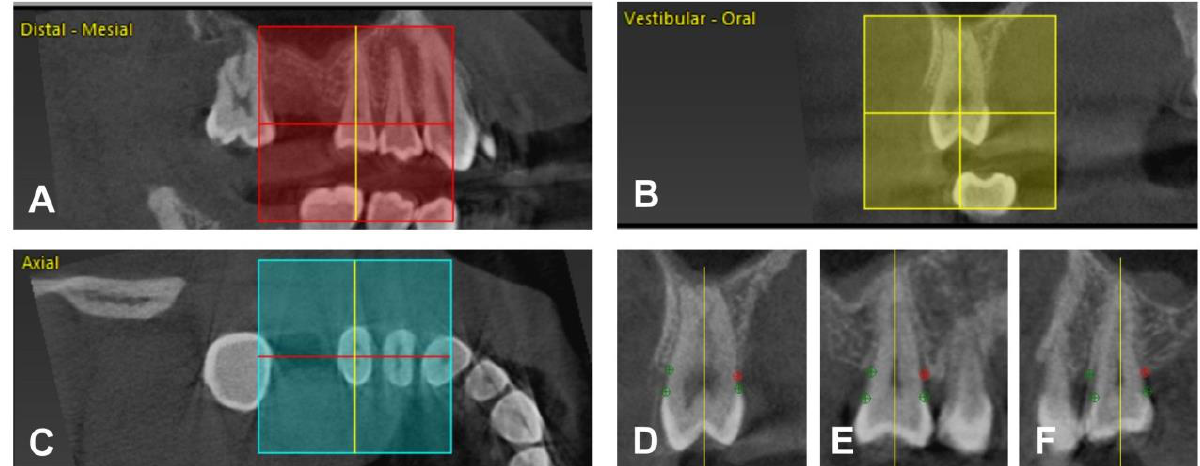
Figure 1. ( A – C ) Tooth selection and positioning. Tooth 15 in a distal-mesial ( A ), vestibular-oral ( B ), and axial ( C ) plane. The crosshair is positioned according to the longitudinal axis and CEJ or RM ( A , B ) and parallel to the cross-axis of the tooth ( C ). Every single tooth was selected and adjusted manually. ( D – F ) Setting the reference points. The yellow line marks the longitudinal axis of tooth 15. It is presented in three different cross-sections, oral/vestibular ( D ), vestibular-distal / oral-mesial ( E ), and vestibular-mesial/oral-distal ( F ). Twelve reference points per tooth (as depicted in green and red color) were set on the CEJ or RM and AC for each side. The red dot marks the AC oral ( D ), oral-mesial ( E ), and oral-distal ( F ). The software measures RBL by calculating the distance between the dots.